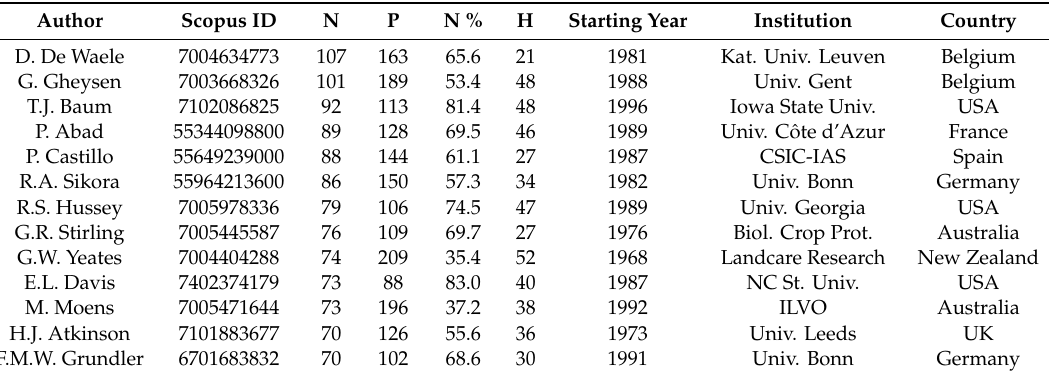
Table 1. Main authors working on publications on nematodes + plants.